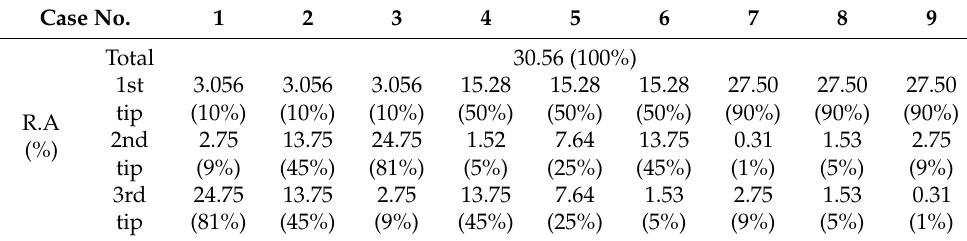
Table 3. R.A of the MRD for the triple die